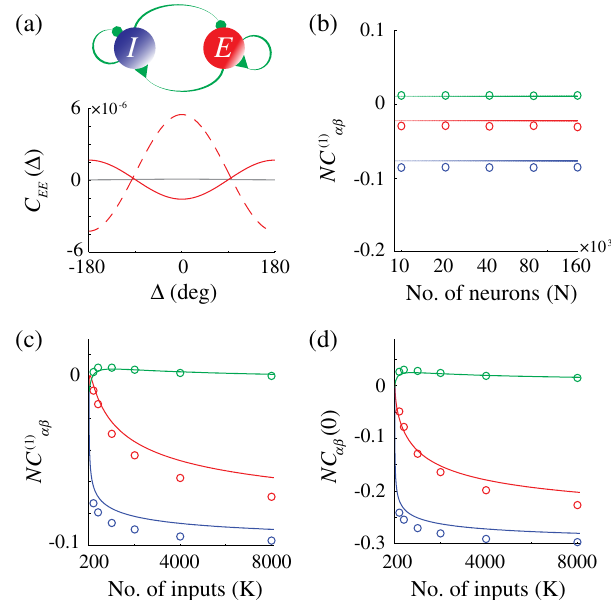
FIG. 2. Correlations in two-population E - I networks. Connec- tion probabilities are as in Eq. (29). Panels (a),(c),(d): N ¼ 40 000 . (a) Top panel: The network architecture. All connections are 1 Þ ≠ 0 ). Bottom panel: Simulation results spatially modulated ( f ð αβ with K ¼ 2000 . Red: f ð 1 Þ f ð ¼ 0 . 25 . For comparison, the correlation is also plotted for II